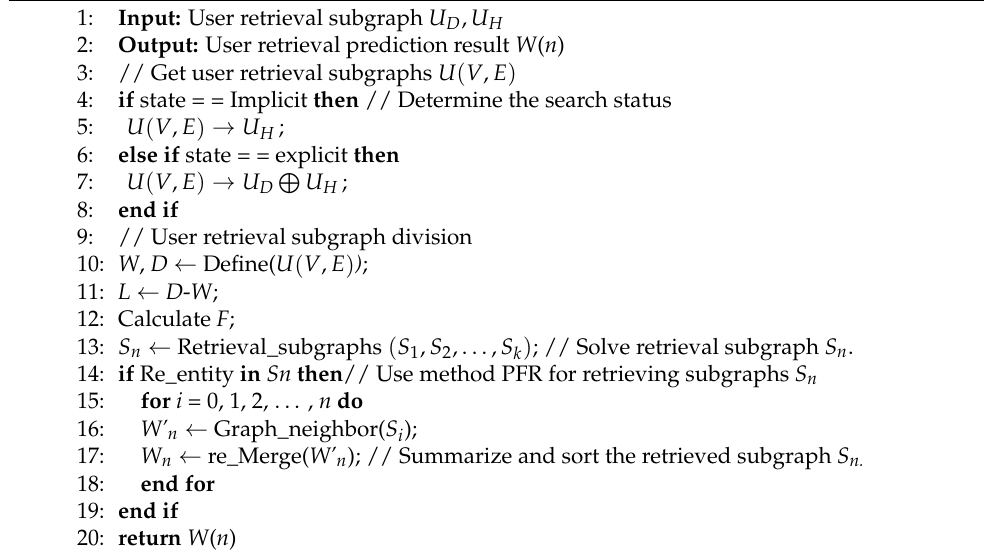
Algorithm 2: User Polymorphic Retrieval Recommendation Model